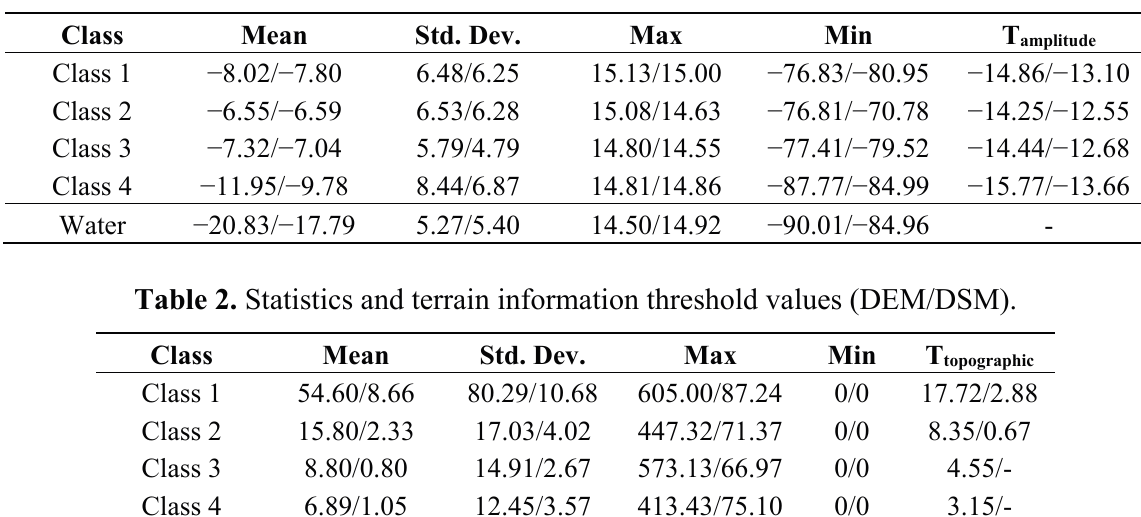
Table 1. Statistics and SAR amplitude threshold values (08.03/08.23).